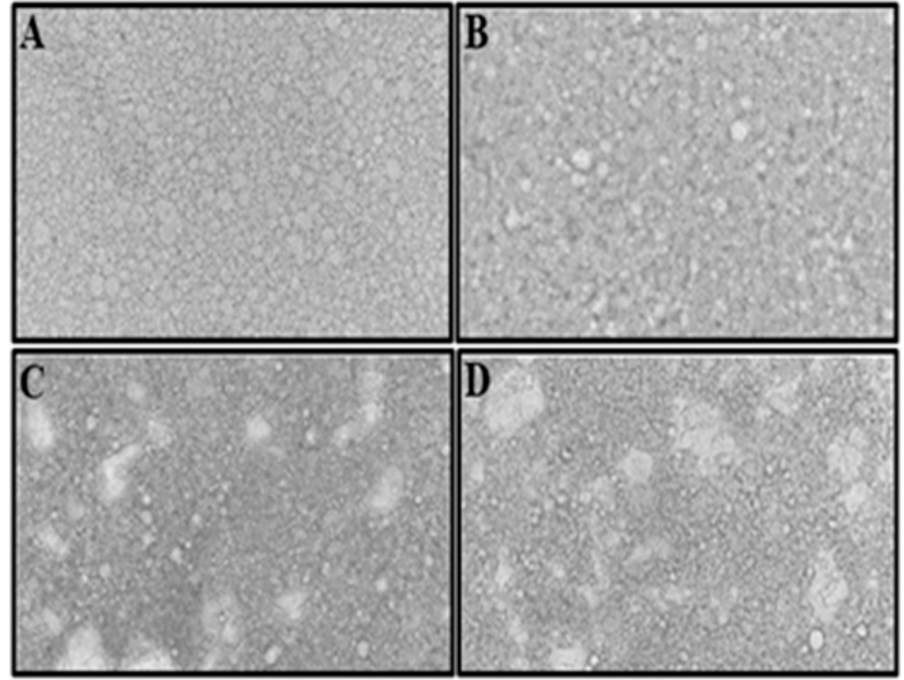
Figure 1. Optical microscope graphs of full-fat mayonnaise ( A ) and mayonnaise with ( B ) 25%, ( C ) 50%, and ( D ) 70% substitution of oil with Gurma melon pulp gel (GMPG).